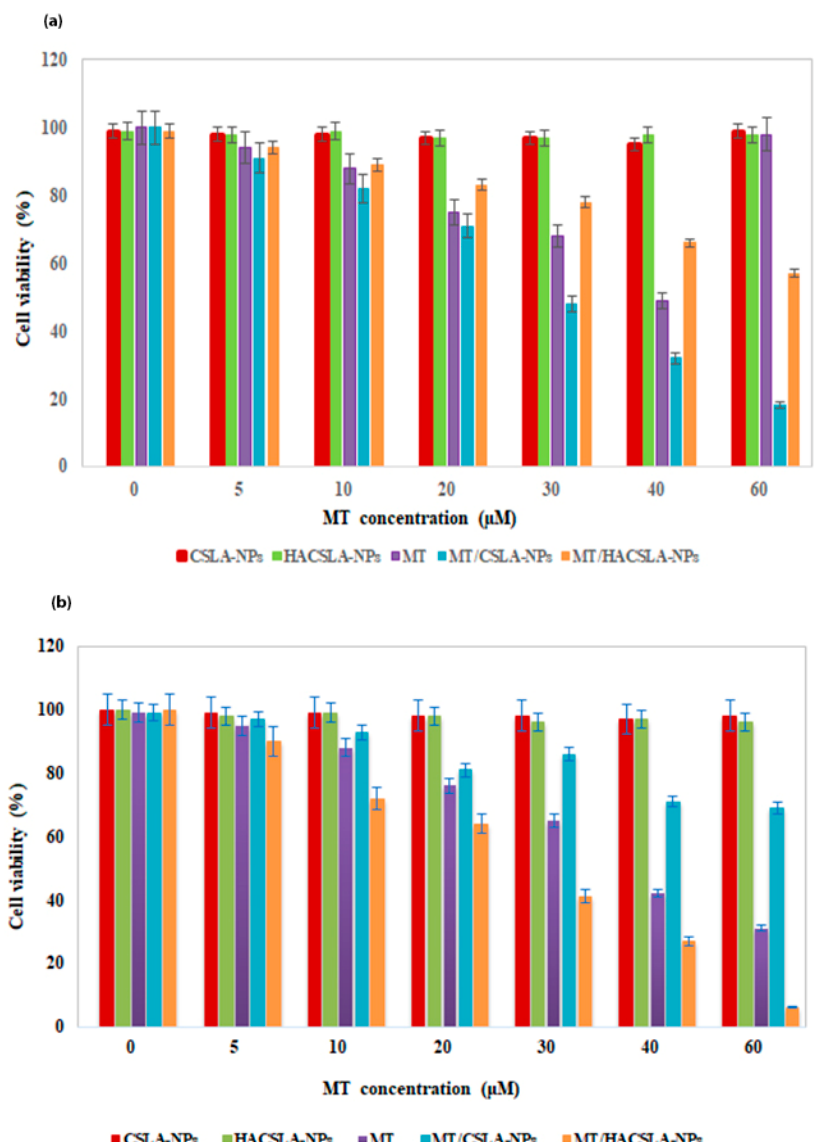
Figure 6. The effects of different MT concentrations (0.0–60 µM) on the cell viability on ( a ) Michigan Cancer Foundation-7 (MCF-7) and ( b ) BT-20 cells. All data represented by mean ±S.E.M ( p < 0.05).